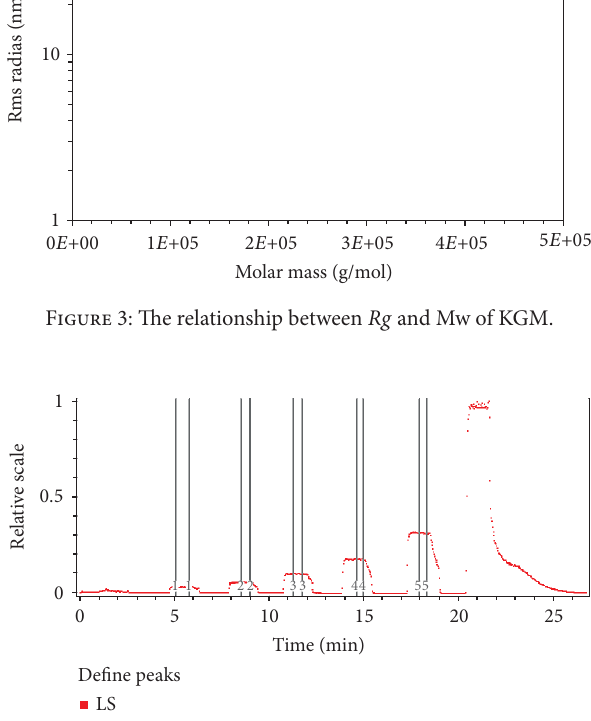
3.3.2. Zimm Plot of KGM. Zimm was a series of straight lines according to the dependence of angle between different concentrations macromolecules and the strength of scattered light. erefore weight-average molecular weight (Mw) and the second coefficient ( ) have been deduced. 𝐴𝐴 2